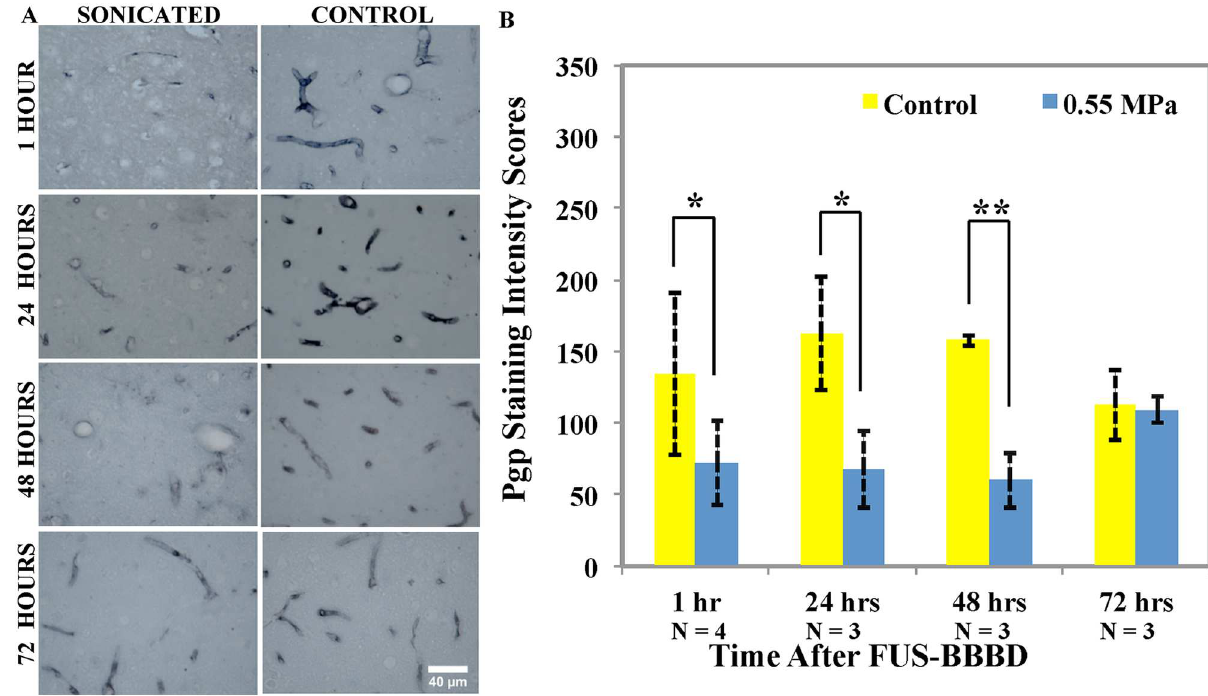
Fig 4. A. Representative microphotographsfrom regions in the sonicatedand control hemispheres at different time points after BBBD inducedby microbubble-enhancedsonicationat 0.55MPa. Stainingintensity was clearly reducedat one, 24, and 48 hours, but not at 72 hours. Fig 4. B. Pgp stainingintensity scores at different time points after FUS-induced BBBD at 0.55MPa. A comparisonof Pgp immunostaining in sonicatedand control hemispheres revealedstatistically significantdifferencesin animalsthat were sacrificedone, 24 and 48 hours after BBBD (p < 0.05, p < 0.05,p < 0.01,respectively), but not at 72 hours (p = 0.43). Scale bar: 40 μ